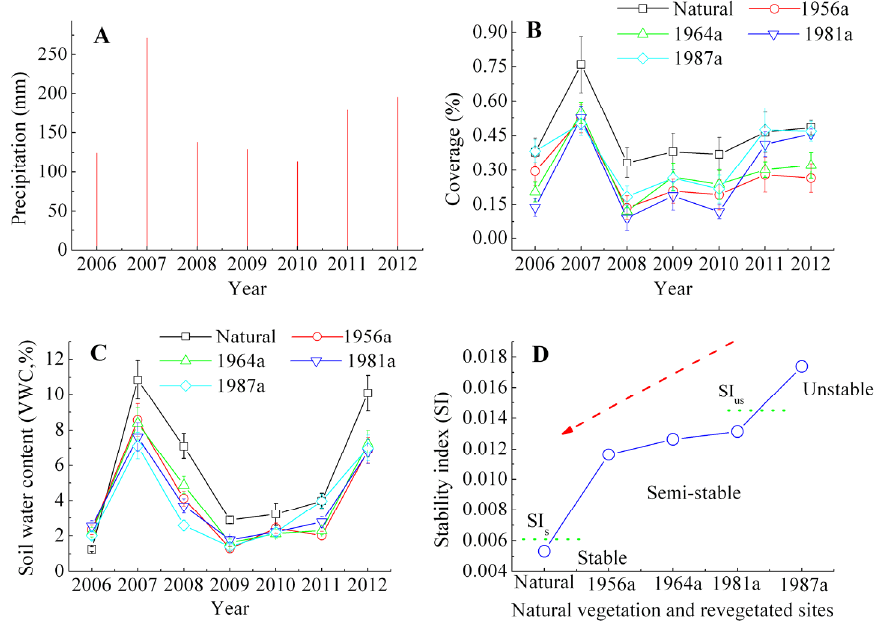
Figure 3. ( A ) Annual precipitation; ( B ) plant coverage; ( C ) soil moisture and ( D ) stability index of different vegetative sites and the control; The horizontal dashed lines represents the threshold of ecosystem stability, SI s = 0.004, SI us = 0.015.